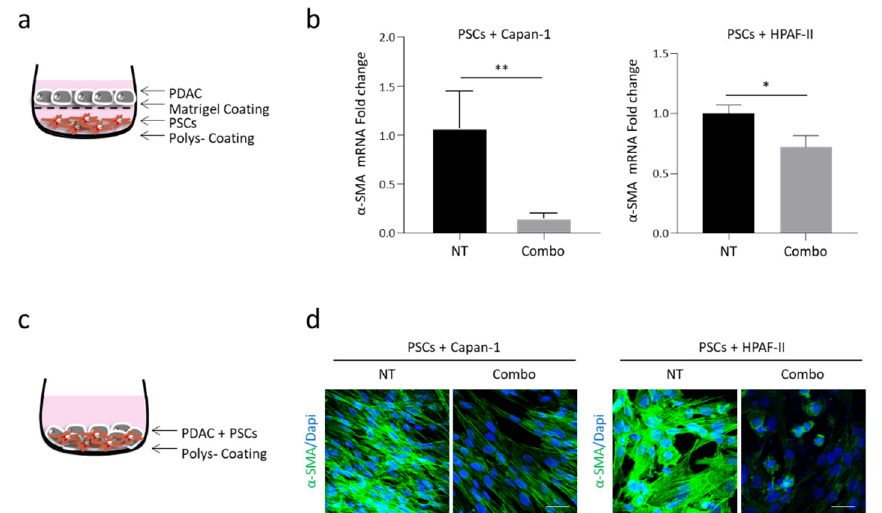
Figure 1. Concomitant HGF/MET inhibition reduces α -SMA expression by human pancreatic stellate cells (PSCs) co-cultured with human PDAC cells. ( a ) Schematic representation of the indirect co-culture model: PSCs were seeded in the lower chambers and PDAC cells in the upper chambers of a transwell plate. ( b ) α -SMA-specific qRT-PCR analysis of mRNA derived from human PSCs co-cultured with Capan-1 (left panel) or HPAF-II (right panel) PDAC cells treated with MvDN30 and decoyMET K842E in combination (Combo). Data are expressed as fold-change values relative to the untreated controls (NT). Each bar represents the average value ± SD. Student’s t test: *, p ≤ 0.05; **, p ≤ 0.01. ( c ) Schematic representation of the direct co-culture model: PSCs and PDAC cells were mixed in 1:3 proportion and plated in the same well. ( d ) Immunofluorescence analysis of α -SMA expression in human PSCs co-cultured with Capan-1 (left panel) or HPAF-II (right panel) cells. Cells were treated as above. Immunofluorescence staining was performed after 5 days of co-culture. Representative confocal sections show α -SMA in green and DAPI in blue. Scale bar is 50 µm. Data reported in figure are representative of at least three independent experiments.